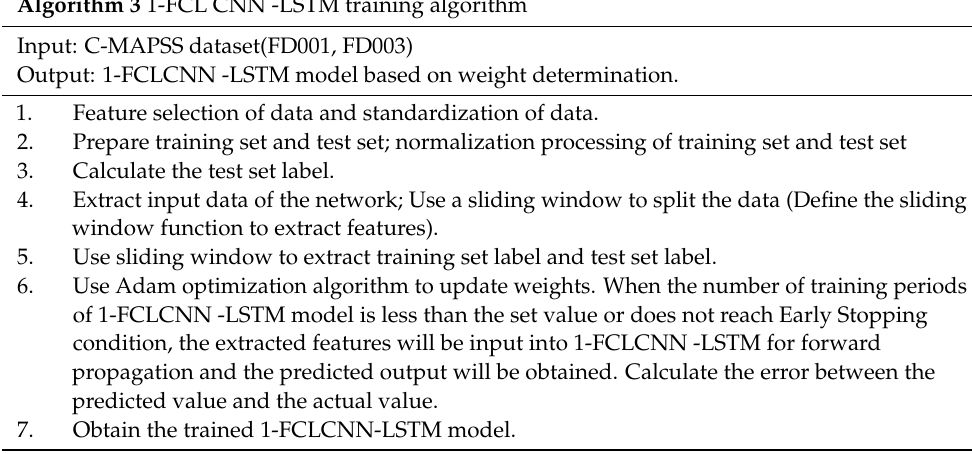
Algorithm 3 1-FCL CNN -LSTM training